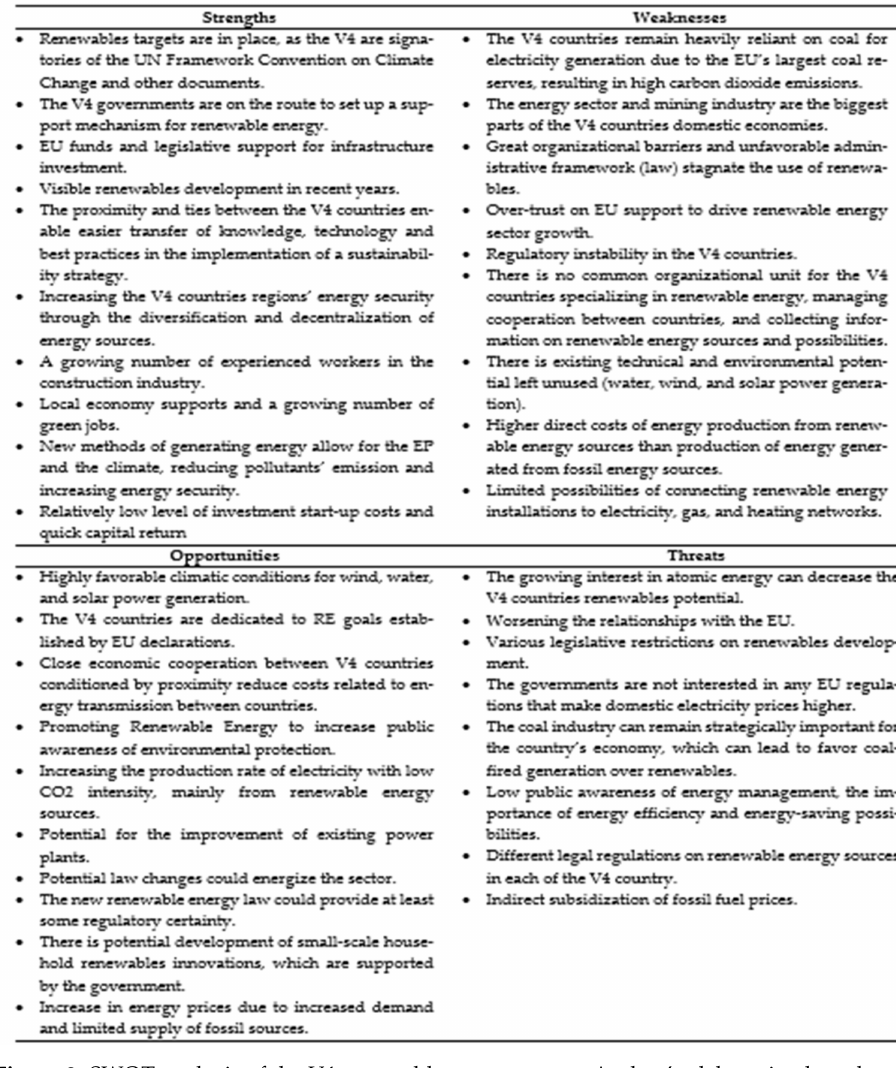
Figure 2. SWOT analysis of the V4 renewable energy sector. Author’s elaboration based on